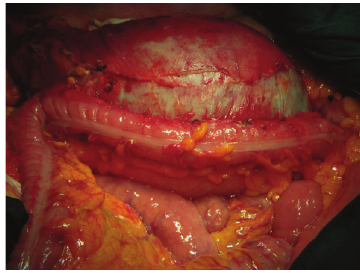
Figure 3: Intraoperative finding—the cystic mass involving the descending mesocolon.